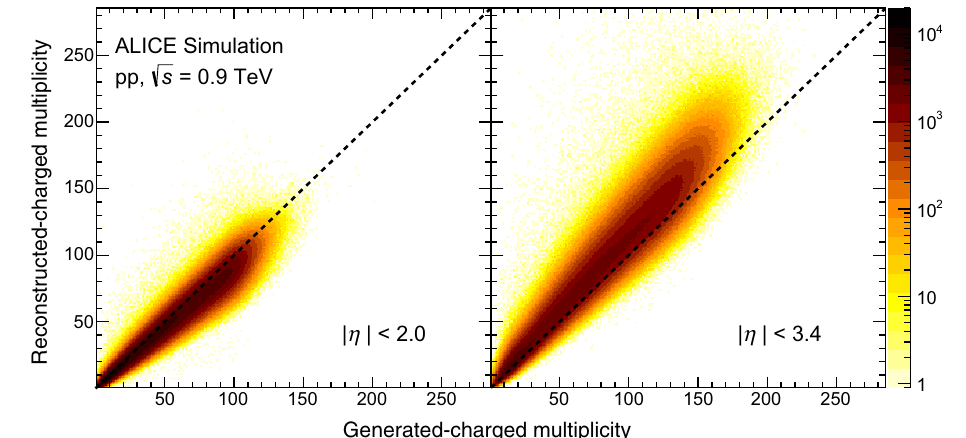
Fig. 1 Response matrices obtained propagating Monte Carlo gener- ated events, in this case with the PYTHIA ATLAS-CSC flat tune [21] for the non-single-diffractive event class selection. Left: Matrix includ-